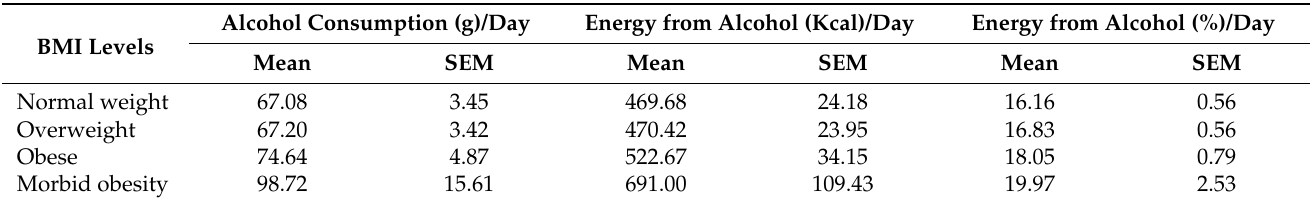
Table 3. Alcohol intake among body mass index (BMI) levels within the group of alcohol